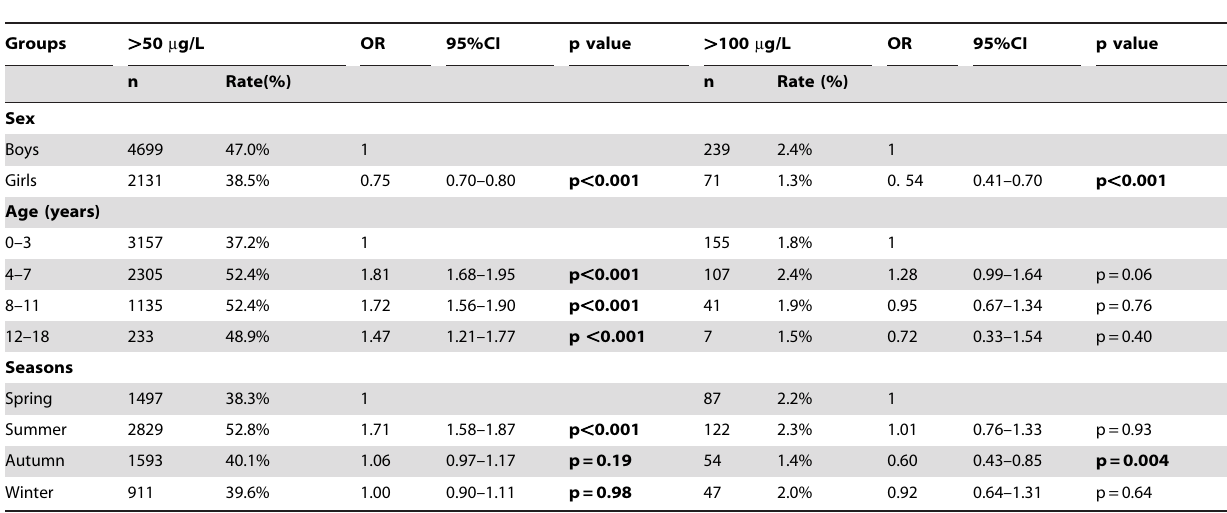
Table 2. High BLL rate at two cut-off points (50 m g/L and 100 m g/L) based on different factors.